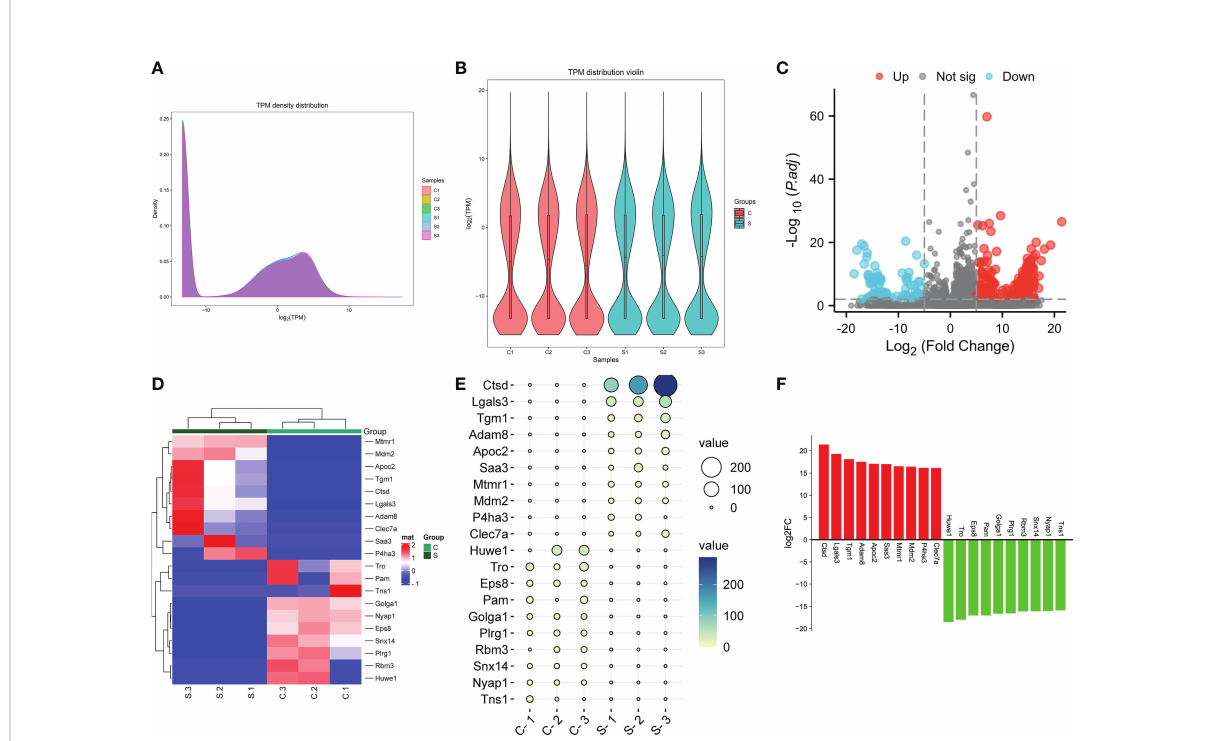
FIGURE 4 The genes were differentially expressed in the subacute stage after SCI in mice. (A) Gene expression density curve. The horizontal axis represent the log (TPM) value, the higher the value, the higher the gene expression level; the vertical axis represent the number of genes on the horizontal axis/the total number of genes. (B) Violin plot of gene expression calculated using TPM. The horizontal axis represent the sample name, and the vertical axis represent the log (TPM) value. The width of each violin re fl ects the number of genes at that expression levels. (C) Volcano plot. Green points indicate down-regulation (left side), gray points indicate undifferential expression (middle), and red points indicate up-regulation (right side). (D) Hierarchical clustering shown the top 10 upregulated and top 10 downregulated genes. with rows indicating DECs and columns indicating samples. (E) Ballon plot. The size of the circle shows the size of each value in the matrix, and the size of the value is represented by the shade of color. (F) Bar plot shown the top 10 upregulated and top 10 downregulated genes in SCI tissues. The X-axis represents gene and the Y-axis represents log2 fold change. Red means up-regulation, above the X-axis; green means down-regulation, below the